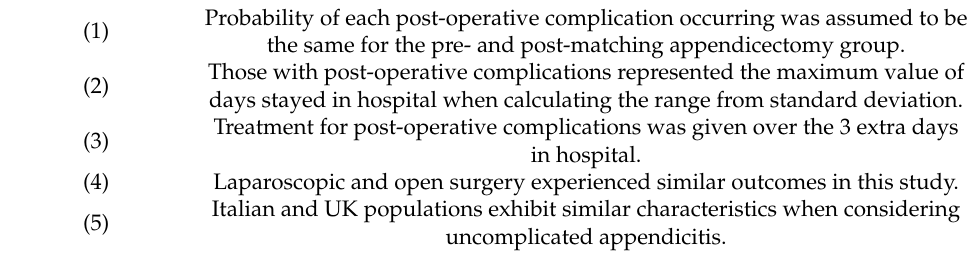
Table A5. Key assumptions made in the